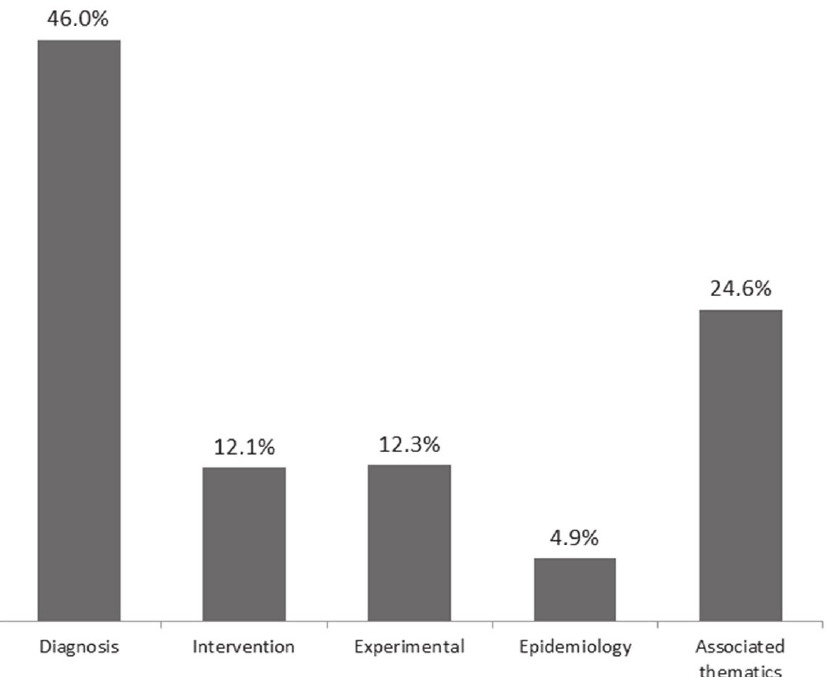
Figure 2- Thematic approaches of scientific works registered in CAPES Theses Database from 2001 to